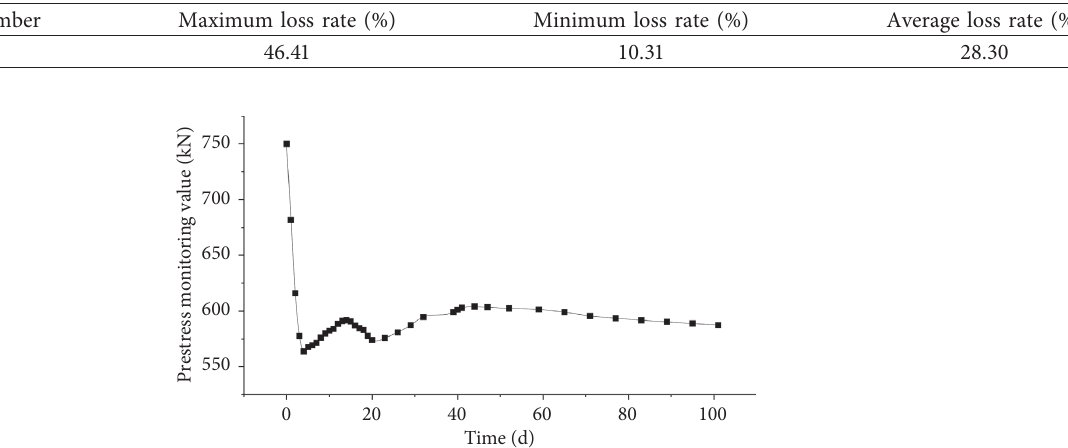
Table 3: Long-term loss rate of anchor cable.